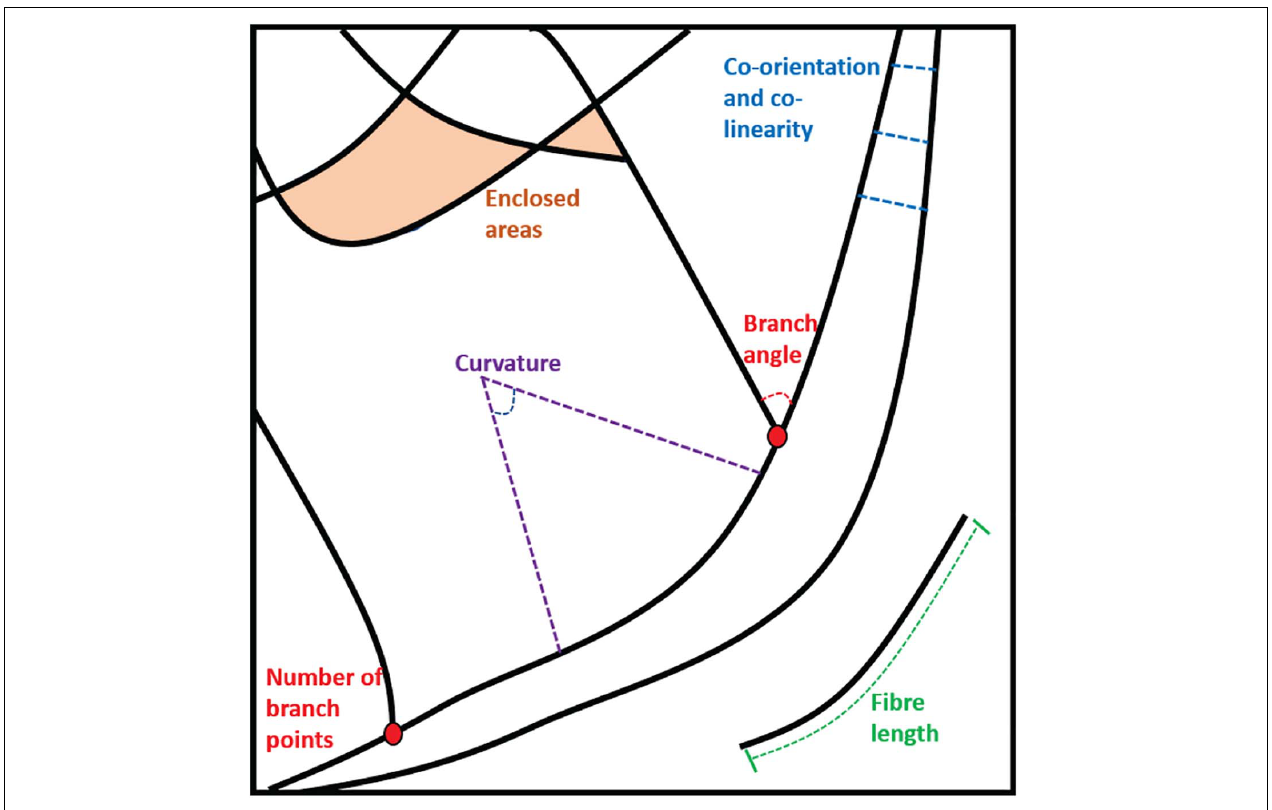
FIGURE 2 | Examples of the parameters that can be extracted from static fiber analysis: Enclosed areas, branch points and angles, fiber lengths and measures of curvature, co-orientation, and co-linearity.